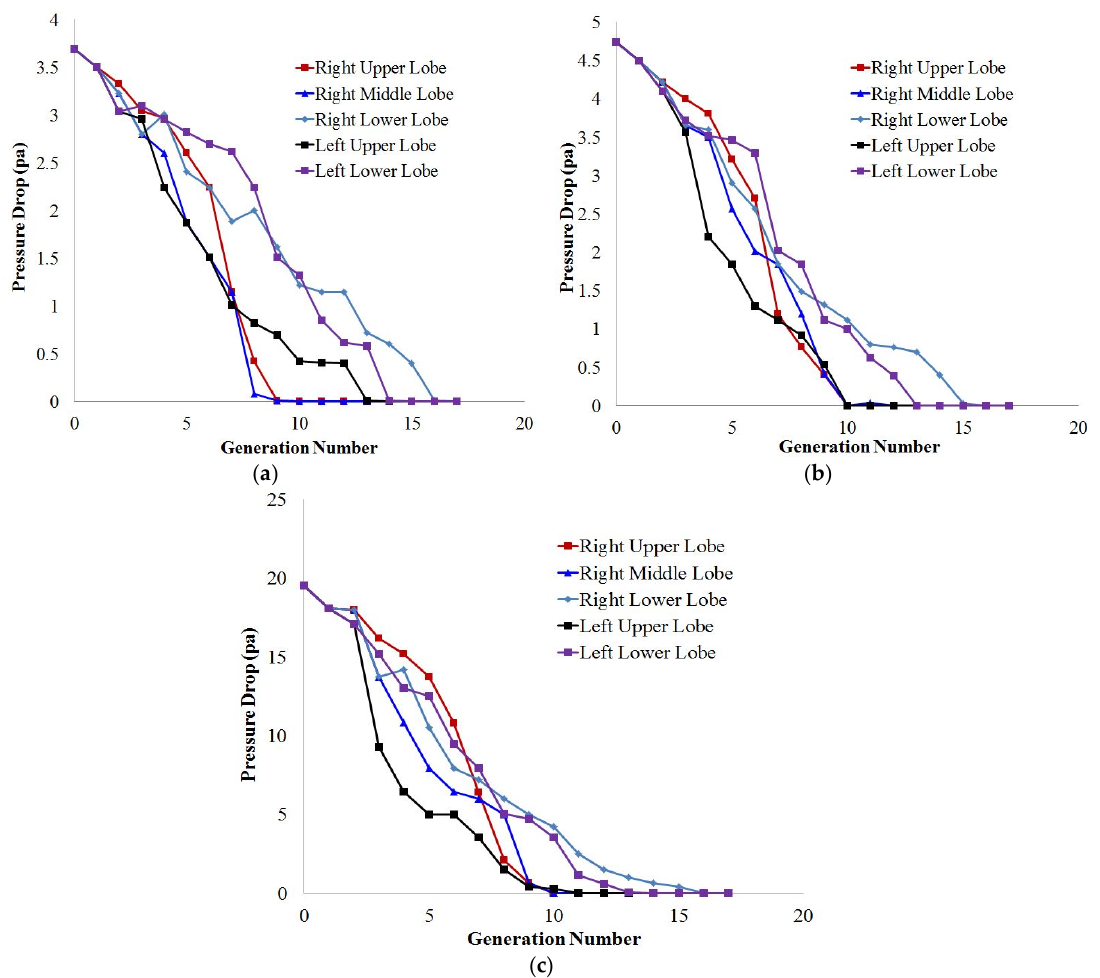
Figure 3. Pressure drop along a selected path line of lobes. ( a ) 7.5 lpm, ( b ) 9 lpm, and ( c ) 25 lpm [99].